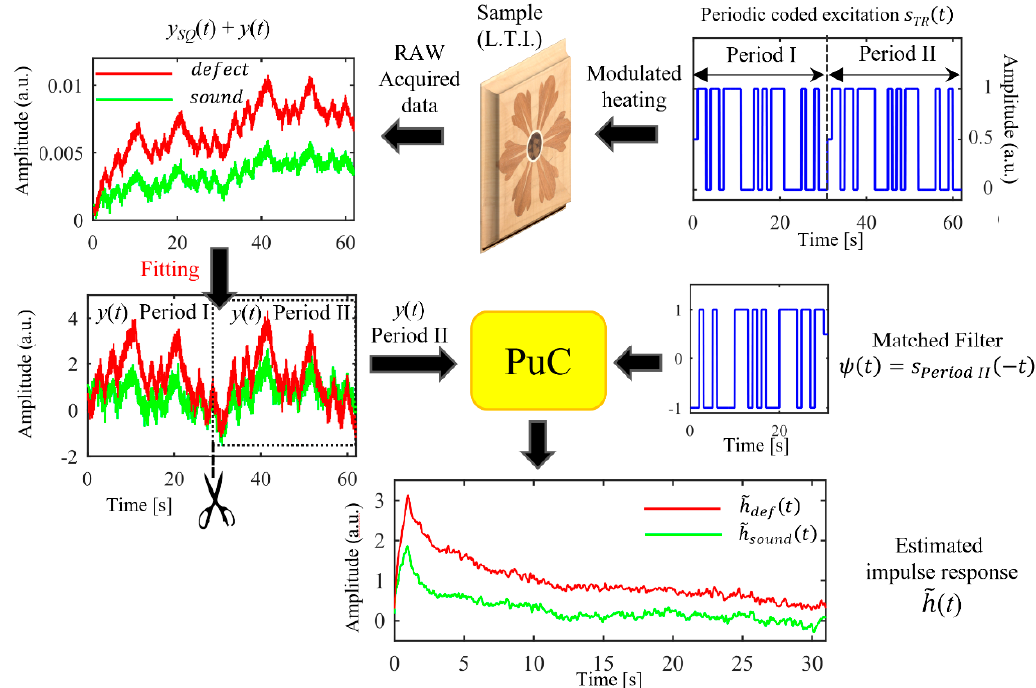
Figure 1. Implementation of the Pulse-Compression Thermography (PuCT) procedure. A coded periodic signal s TR ( t ) modulates the on / o ff state of the LED chips, exciting the investigated sample. A non-linear fit function is applied to the output signal y SQ ( t ) + y ( t ) to remove the step heating contribution y SQ ( t ) and obtain the y ( t ) . The second period of the y ( t ) is then convolved (“PuC box”) with the matched filter ψ ( t ) to obtain an estimate of the sample’s impulse response (cid:101) h ( t ) .